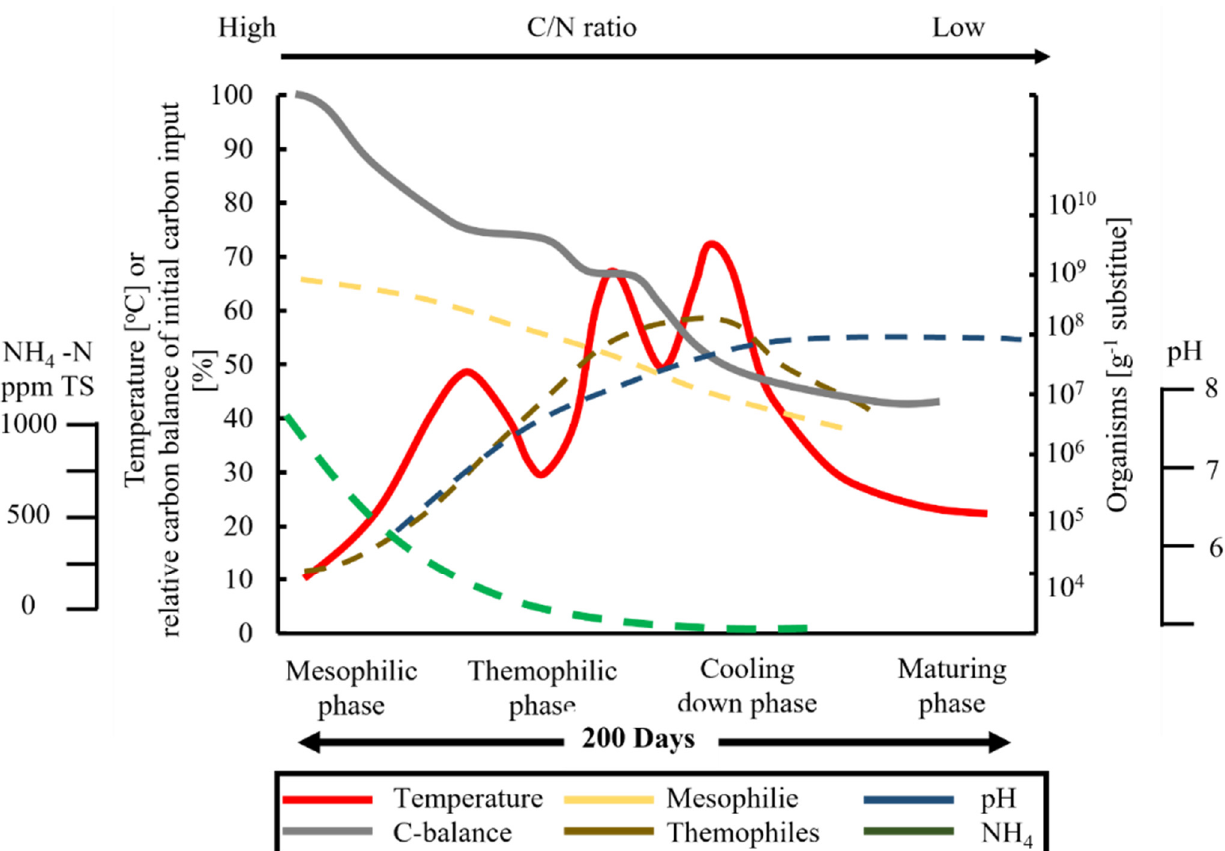
Figure 1. Time, temperature, the progression of compost biota, and further processes during discrete stages in composting.